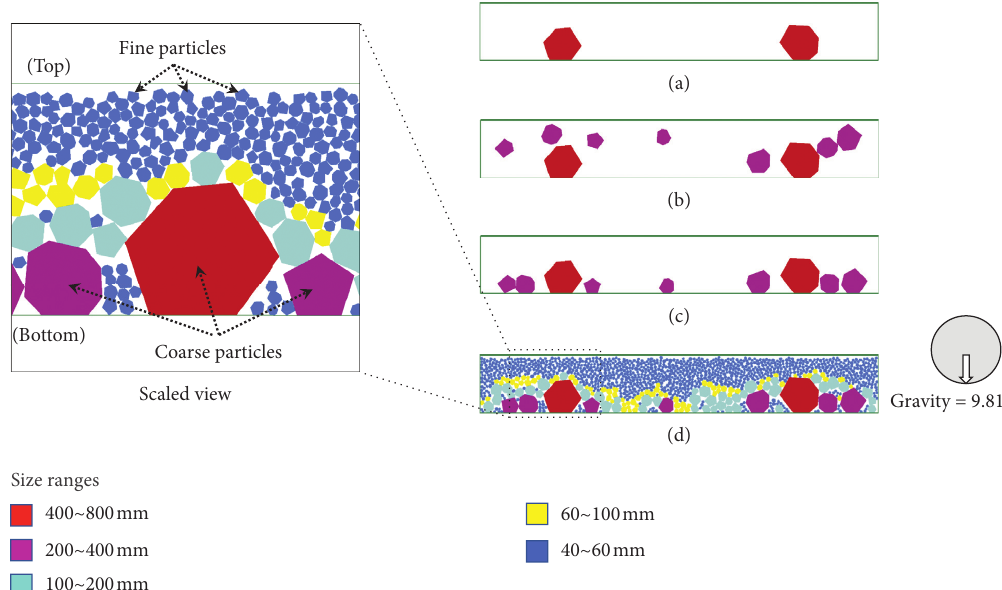
Figure 5: Modeling procedure of field rockfill pavement, considering the effect of